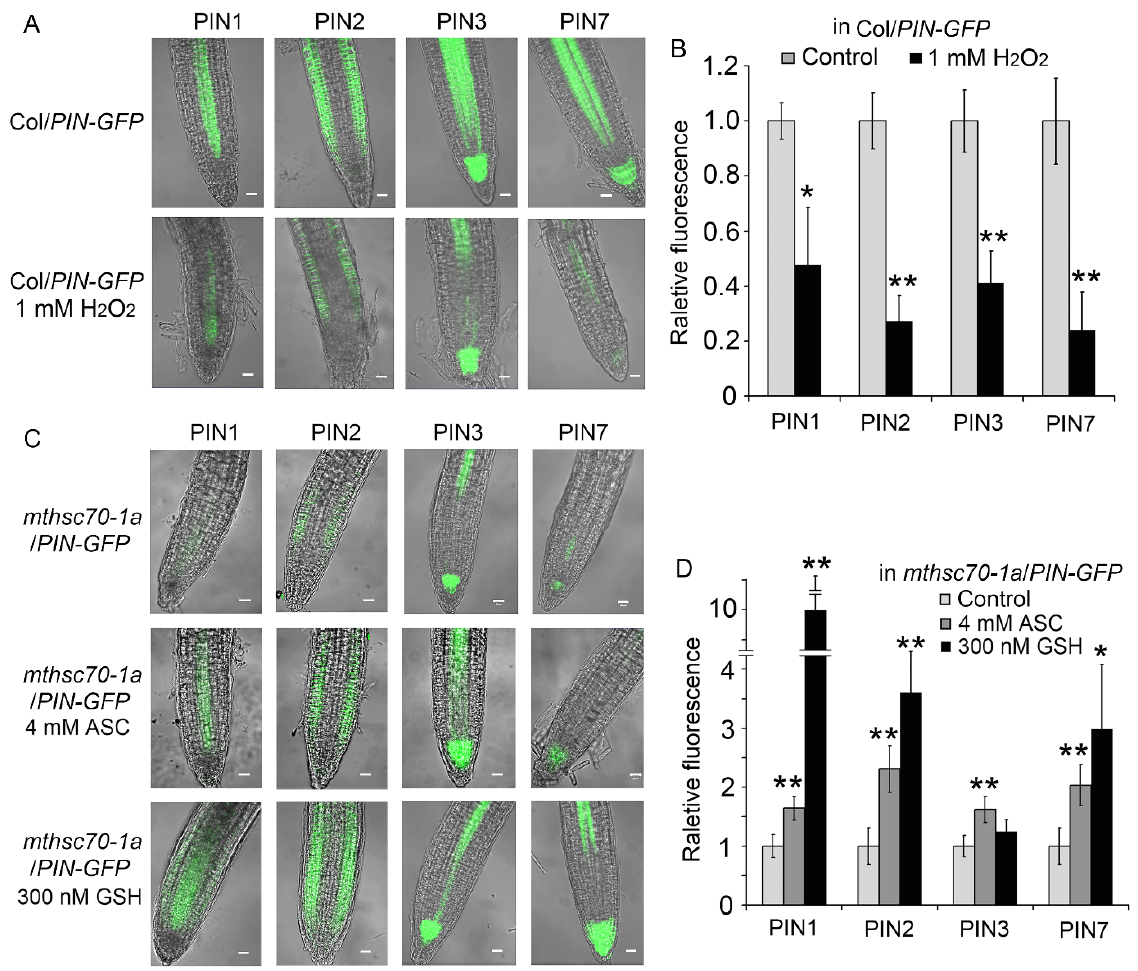
Figure 7. Effects of exogenous redox reagents on PIN protein levels in Col/ PIN-GFP and mthsc70- 1a / PIN-GFP root tips. ( A , B ) Root tips of five days old Col/ PIN-GFP seedlings grown on 0.5 × MS medium with or without 1 mM H 2 O 2 were observed using a LSCM ( A ); the GFP fluorescence intensities were visualized with ImageJ 1.42q software (National Institutes of Health, Bethesda, MD, USA) ( B ). ( C , D ) Root tips of five days old mthsc70-1a / PIN-GFP seedlings grown on 0.5 × MS medium with or without 300 nM GSH (or 4 mM ASC) were observed using a LSCM ( C ); the GFP fluorescence intensities were visualized with ImageJ 1.42q software ( D ). Thirty seedlings from each genotype and treatment were analyzed; representative images are shown. Scale bar = 20 μ m. The asterisks indicate significant differences from the control group ( t- test, *, p < 0.05; **, p < 0.01). Col/ PIN-GFP , Col/ PIN1- , 2- , 3- or 7-GFP plants; mthsc70-1a / PIN-GFP , mthsc70-1a / PIN1- , 2- , 3- or 7-GFP plants.